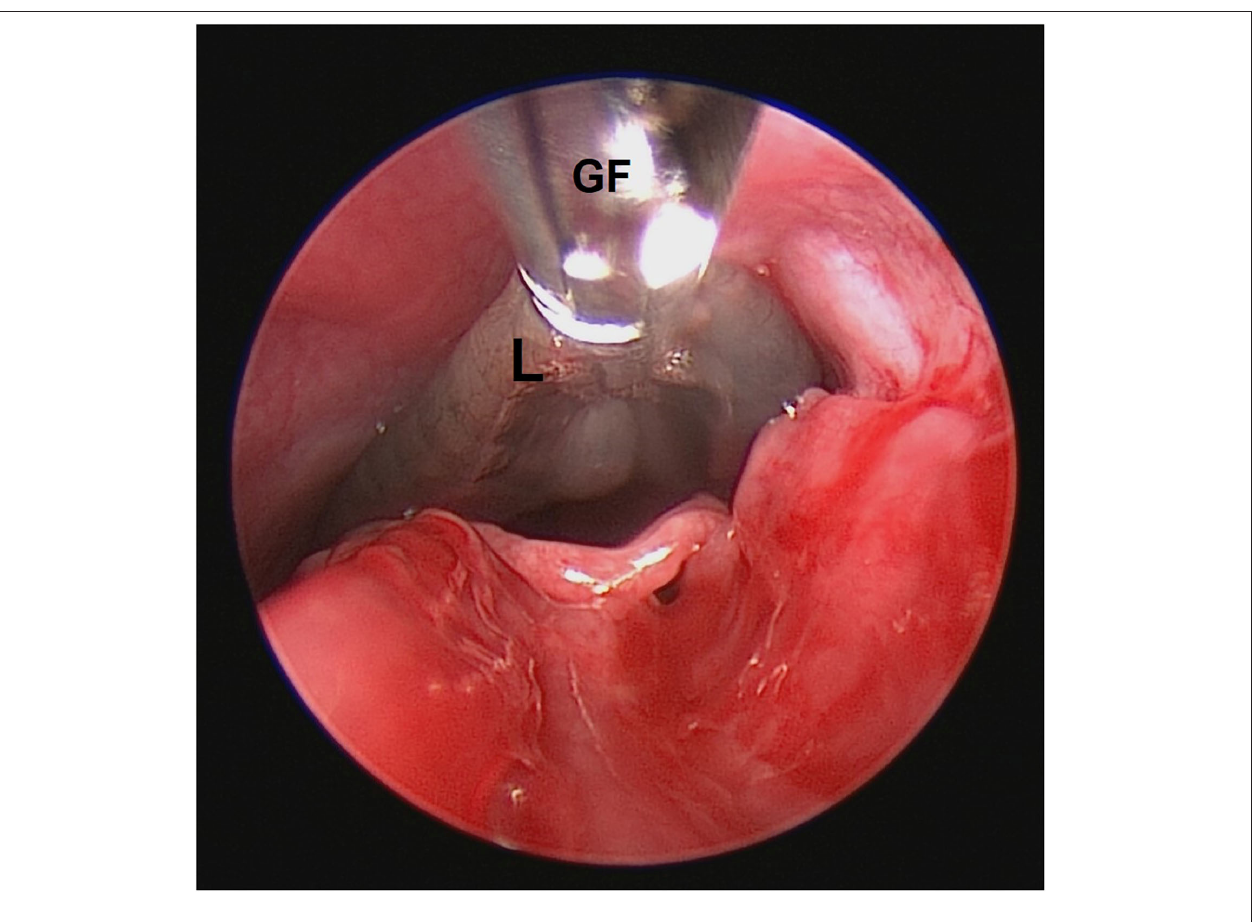
FIGURE 3 | Grasping of leech in nasal cavity. GF, grasping forceps; L, leech.